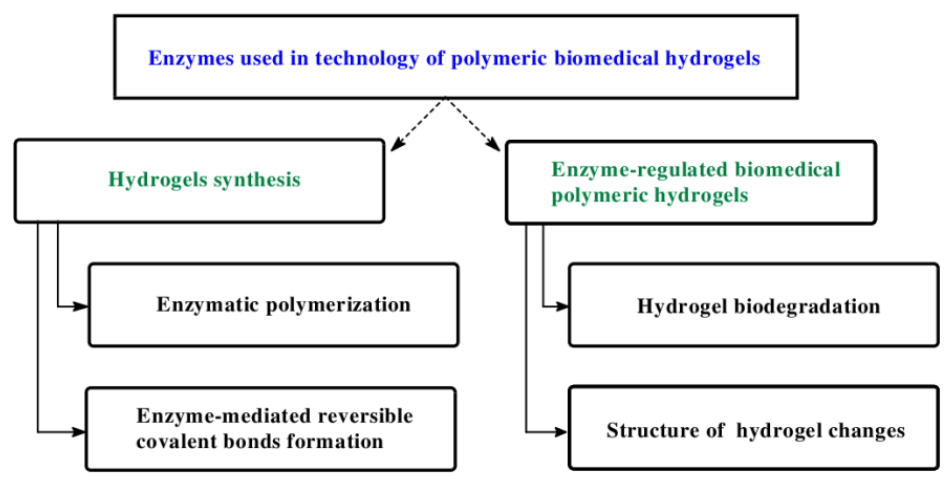
Figure 3. Enzymes used in technology of polymeric biomedical hydrogels. Table 1. Enzymes used in biomedical hydrogels synthesis.